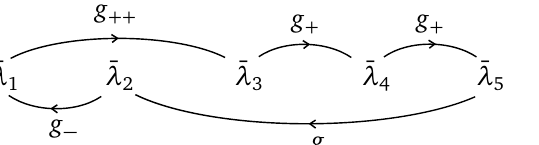
Figure 5: Example of cycle associated with k transformation with a = ¯ a = 1.